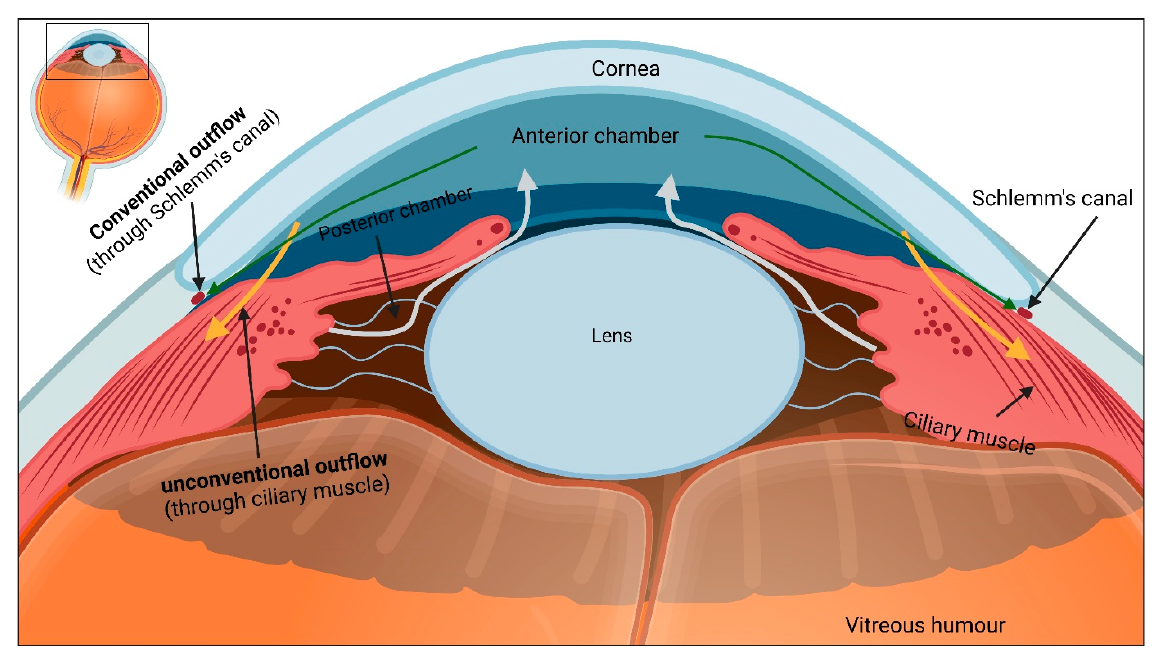
Figure 1. Aqueous humour outflow pathway. After secretion into the posterior chamber, aqueous humour enters the anterior chamber (light grey arrows) and leaves the eye through the trabecular meshwork (green arrows) and uveoscleral route (orange arrows). Figure inspired from [16].